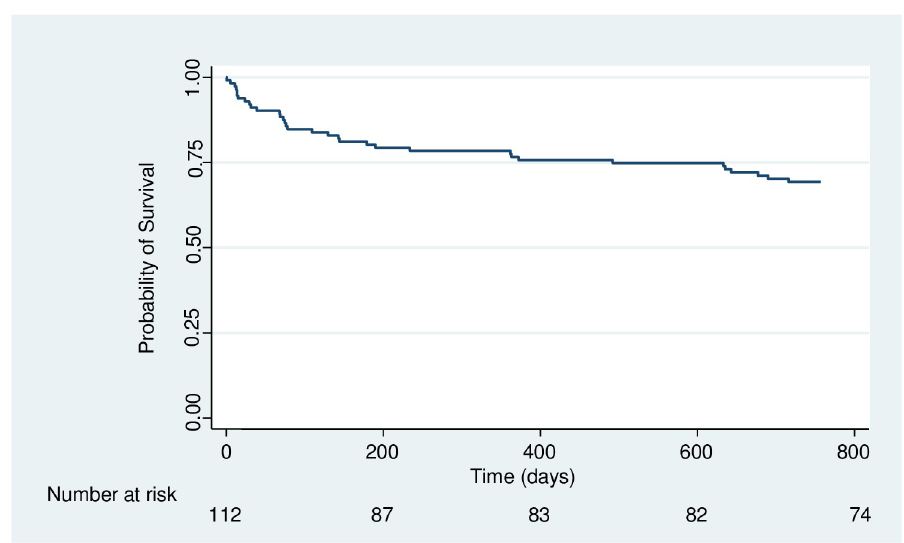
Fig 2. Kaplan-Meier plot showing survival of participants during two years of follow up after completion of recommended therapy.